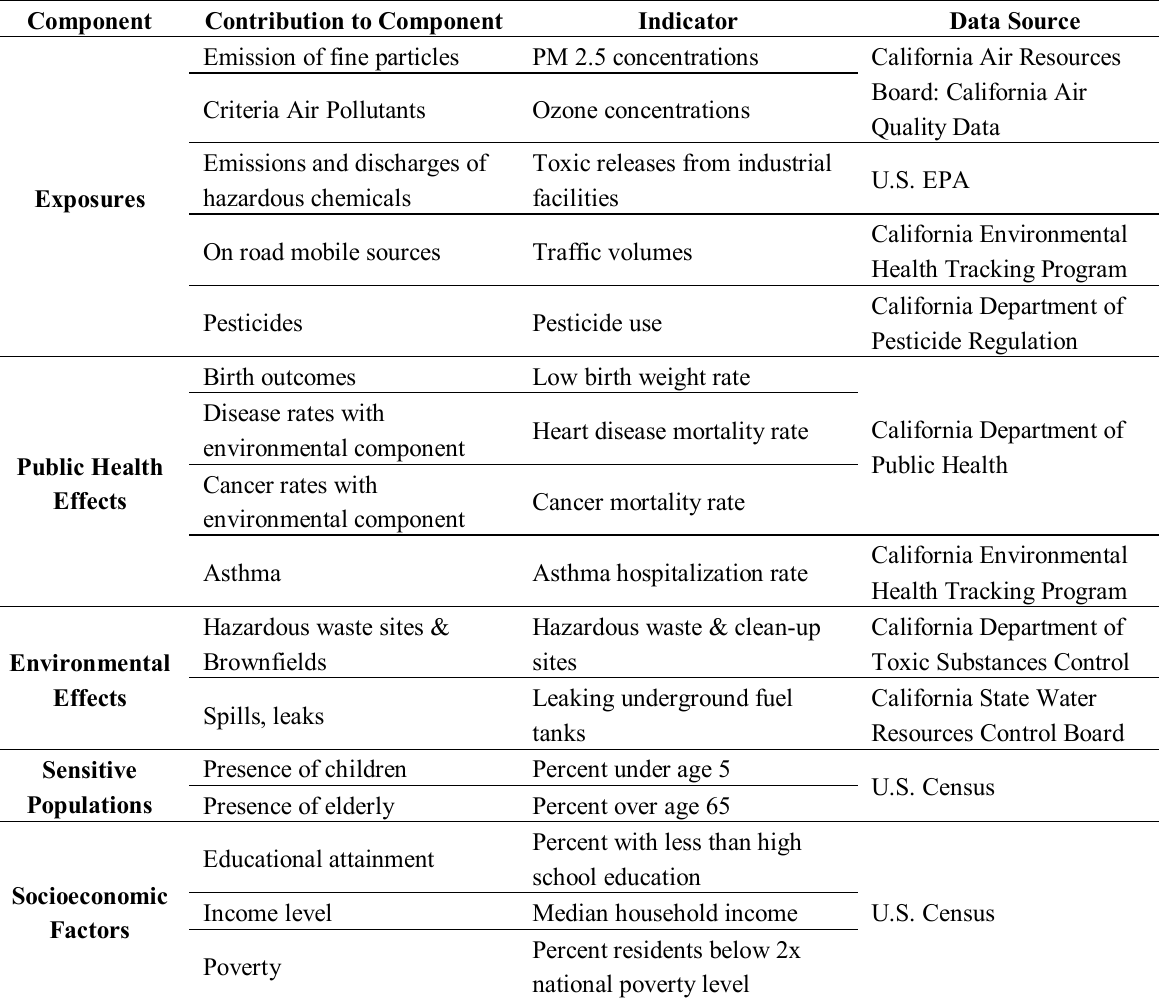
Table 2. Indicators chosen for the pilot cumulative impact